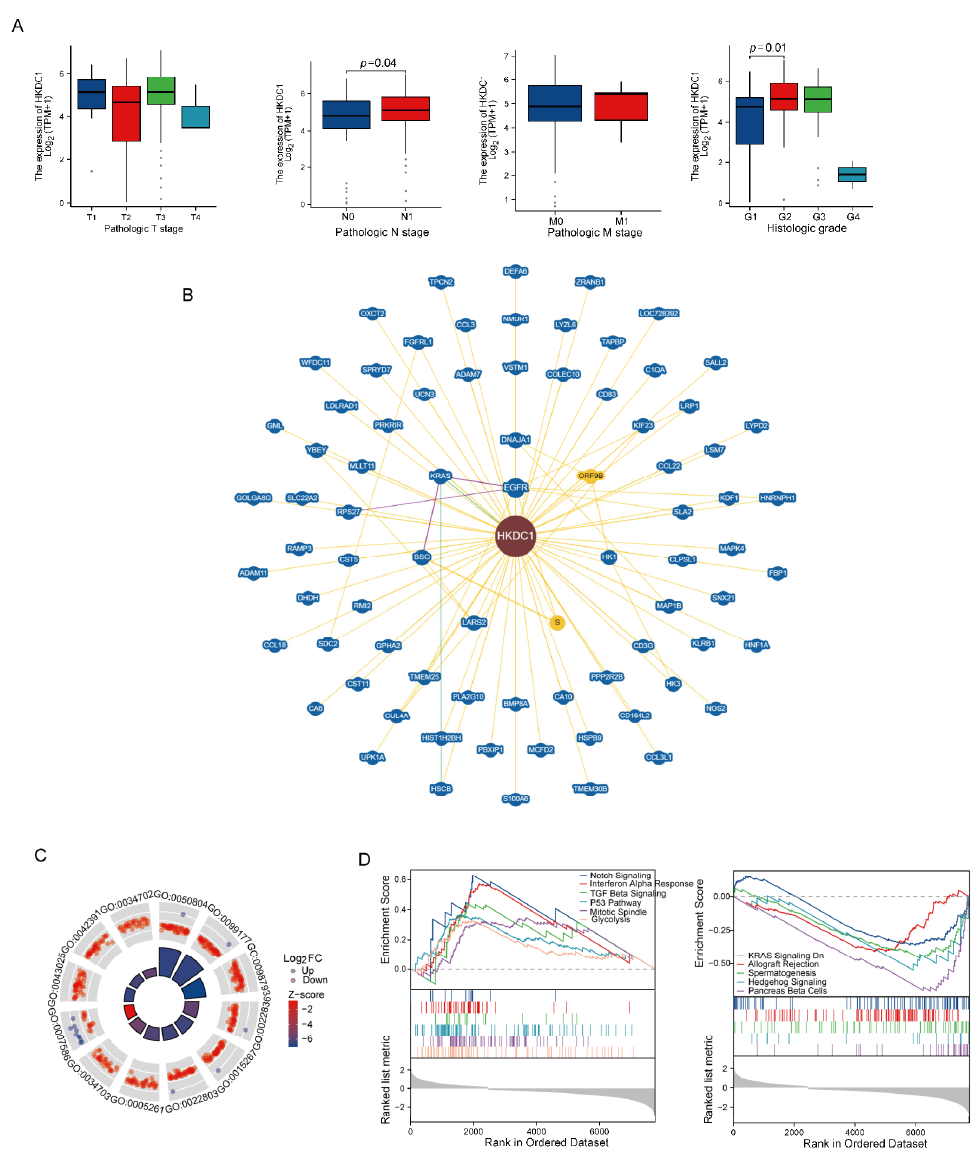
Figure 9. The predictive evaluation of treatment responses for several common chemotherapeutic drugs in PC by the novel prognosis score based on NMG signature. ( A ) The percentage-staked bar plots or boxplot show the distribution of primary clinical features between the high- and low-level HKDC1 groups. ( B ) The molecules interacting with HKDC1 obtained from BioGRID website. ( C ) The GO enrichment analysis of HKDC1 in PC. ( D ) Gene set enrichment analysis (GSEA) analysis of HKDC1 in PC.